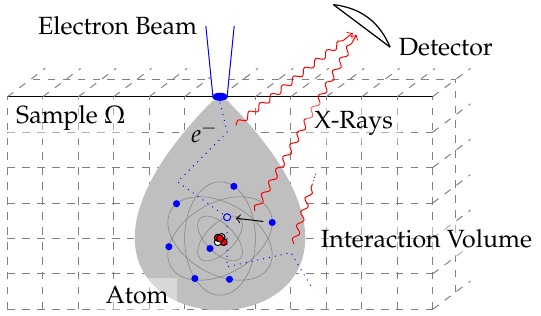
Figure 1. Sketch of the physical processes in EPMA: electron path with multiple collisions ( dotted line ), vacant electron ( hollow circle ), relaxation ( black arrow ), X-ray radiation and attenua- tion/detection ( wavy lines ), and reconstruction pixel ( dashed lines